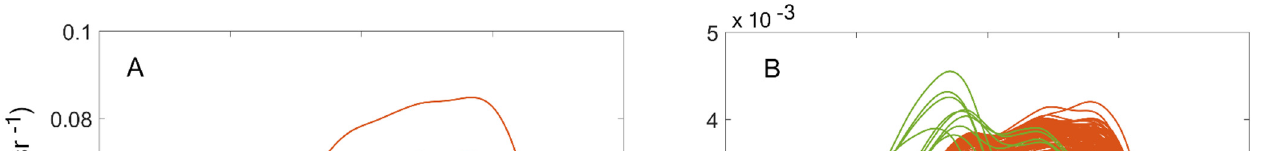
Figure 4. ( A ) Not normalized in situ measured R rs ; ( B ) normalized in situ measured R rs for the Lower Amazon region. The Silhouette method indicated four as the optimal number of OWT classes to be used with the k -means clustering analysis of the in situ normalized R rs between 400–800 nm (Figure 5A). Likewise, the AVW method presented the normalized R rs as a gradient of wavelength values from which four central AVW could be detected (Figure 5B), according to the frequency distribution (histogram, not shown). For the k -means perspective, OWT k1 and k2 are representative of the Amazon River mainstem, OWT k3 is representative of the large CW tributaries (Tapajós and Xingu rivers), and k4 is representative of a mixture of other Amazonian water types, respectively. Herein, the OWT classes are named: k1 as Amazon Optical Water Type 1 (AOWT1), k2 as Amazon Optical Water Type 2 (AOWT2), k3 as Clear Optical Water Type (COWT), and k4 as Mixed Amazonian Optical Water Type (MAOWT) (Figure 4A). The AOWT1 consisted in clustered in situ R rs that were measured during the high, falling, and low water in the Amazon River (T1, T2, T3, and T5; see Figure 1C). The AVW of AOWT1 comprises the interval 584 nm ≤ AVW ≤ 598 nm, with the central wavelength at 590 nm (Figure 5B). Nevertheless, AOWT2 has an increasing reflectance in the same interval (green to NIR; see Figure 5) as a result of the immense input of sediments during the rising water season [66], with the central wavelength shifting to 605 nm in the range of 593 nm ≤ AVW ≤ 612 nm (Figure 5B). The AOWT2 class is primarily composed of water present during the period of rising water and high water seasons, corresponding to T4 and T6 field campaigns, respectively (Figure 1C).